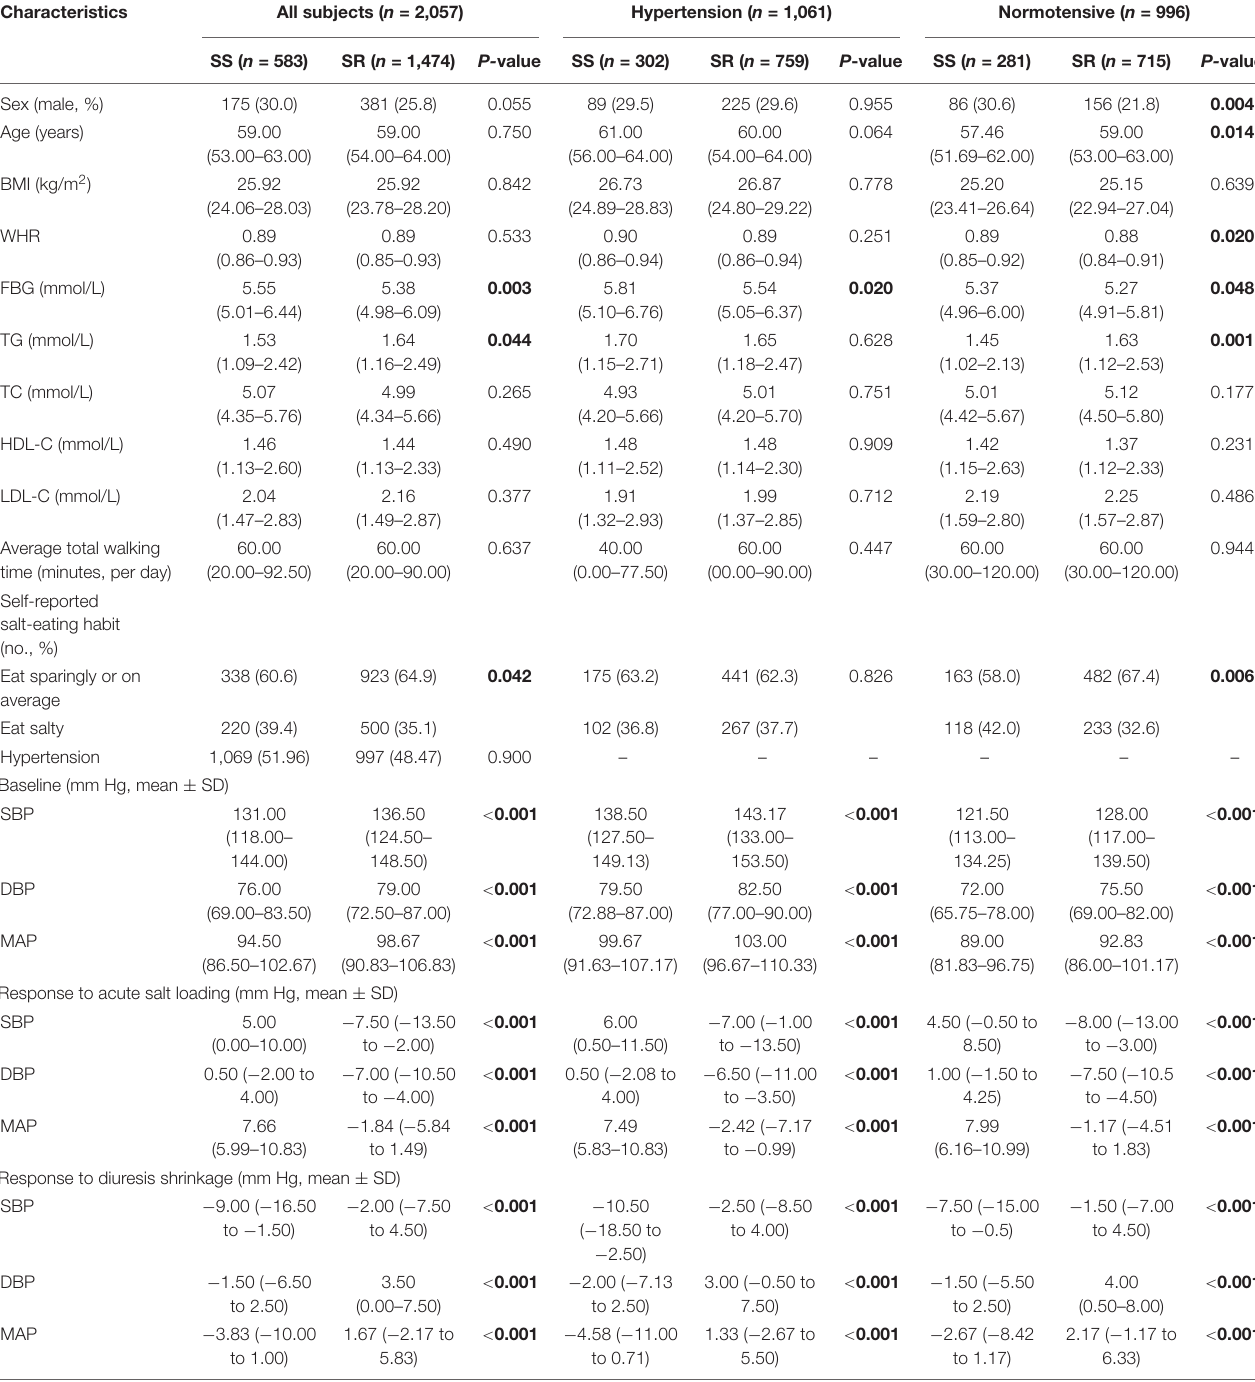
TABLE 1 | Demographic and clinical characteristics of